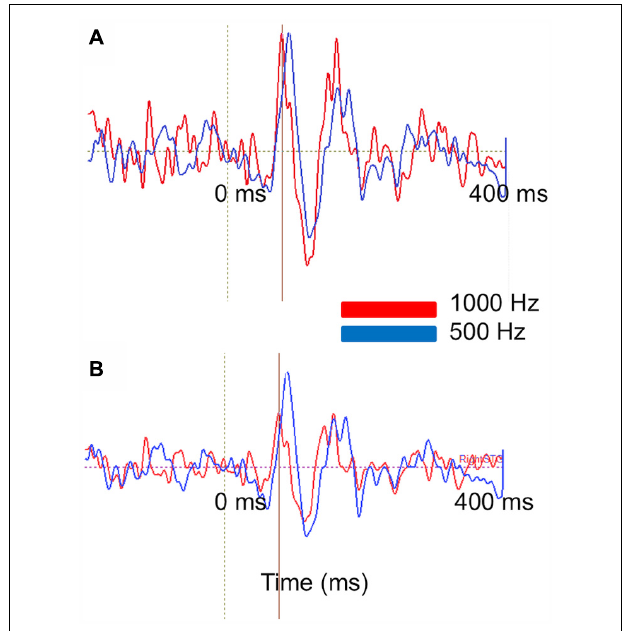
FIGURE 9 | Stimulus attribute (frequency) encoding is reflected at both the sensor and source levels. (A) PCA on MEG auditory evoked sensor waveforms comparing a 1000 Hz (red) and 500 Hz (blue) auditory response in an 18-month-old-subject.Waveforms are shown from − 200 to 400 ms. (B) Right superior temporal gyrus source waveforms in the same subject. Time courses are shown from − 200 to 400 ms. At sensor and source